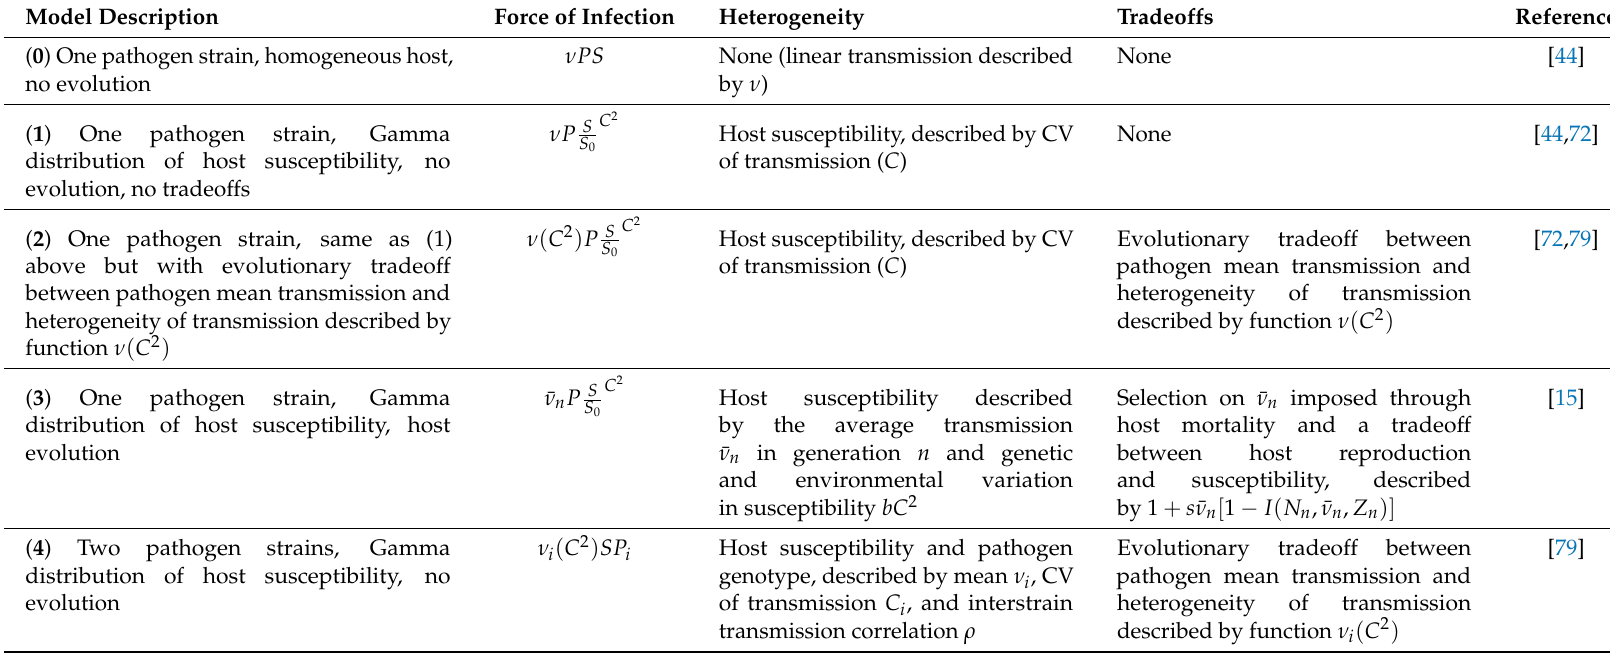
Table 1. Models used to compare effects of biocontrol on population dynamics and the equilibrium population size of host pest insects. ¯ ν is mean transmission rate, C is the coefficient of variation of transmission, S 0 is initial density of susceptible hosts, P is pathogen density, b is heritability, s is the slope of fecundity and transmission, and i indicates pathogen strain i . The function I ( N n , ¯ ν n , Z n ) quantifies the fraction of insects killed by virus and is thus a selective force on ¯ ν . Mode numbering begins at zero, as Model 1 converges to the linear transmission model when heterogeneity approaches zero, and thus Model (0) is not referenced later in this